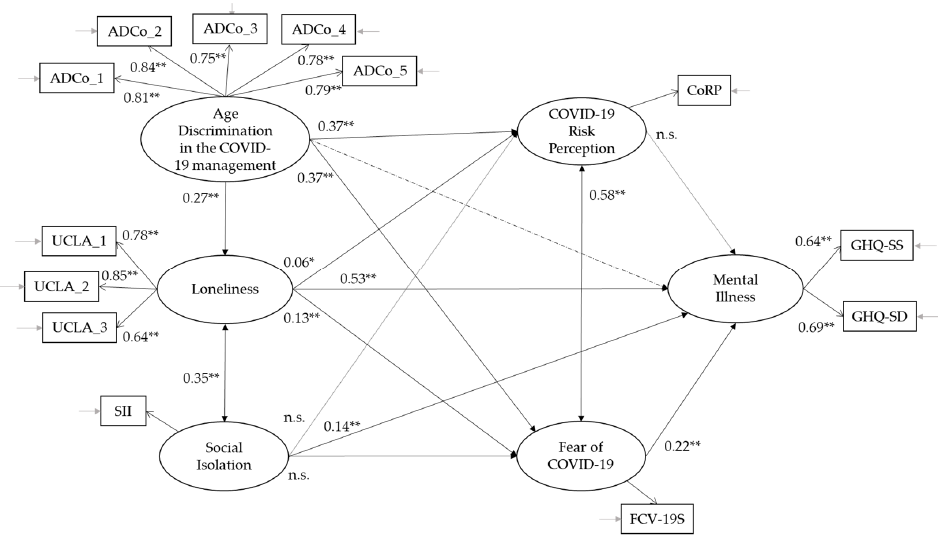
Figure 2. Structural equation models with standardised coefficient estimates (** p < 0.001; * p = 0.05; n.s. = not